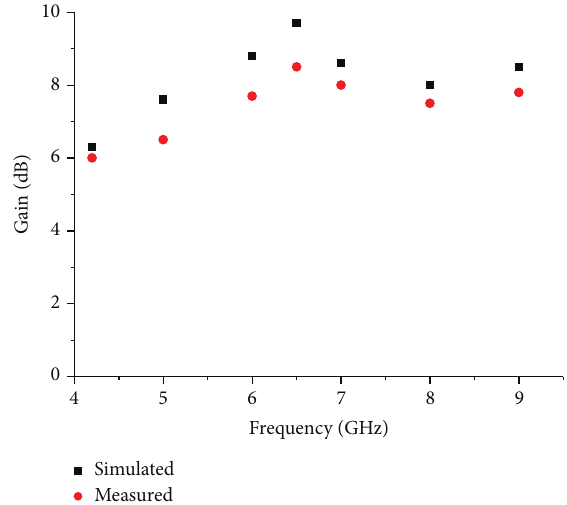
Figure 9: Simulated and experimental gain of proposed antenna.